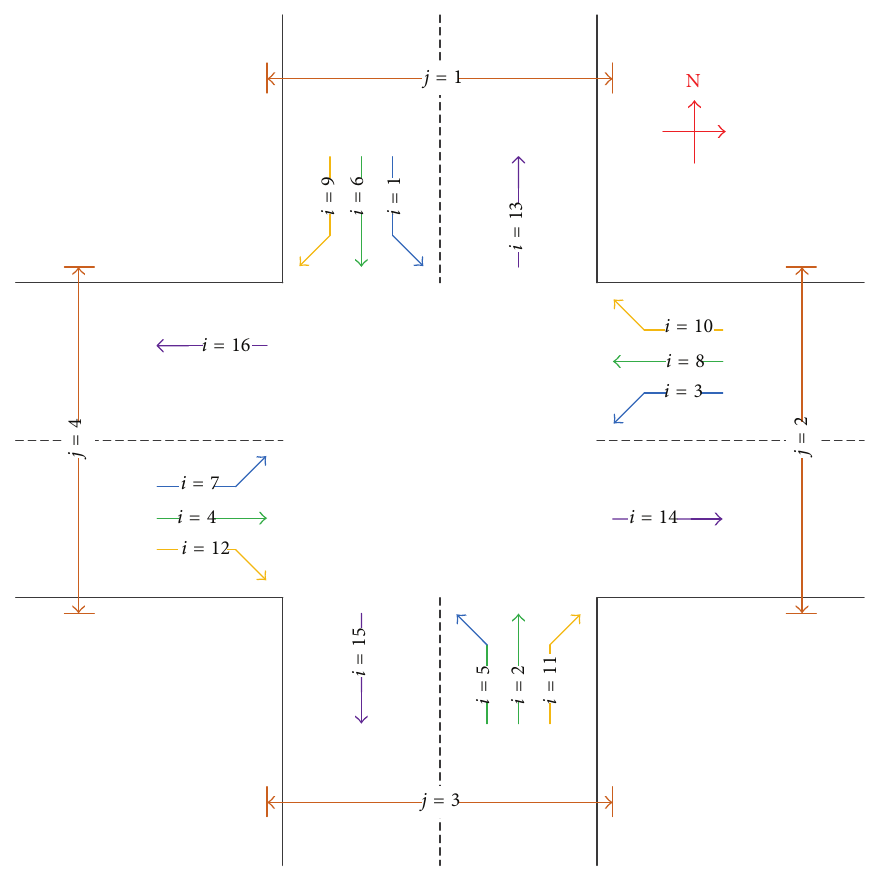
Figure 1: Semantic coding of approach and